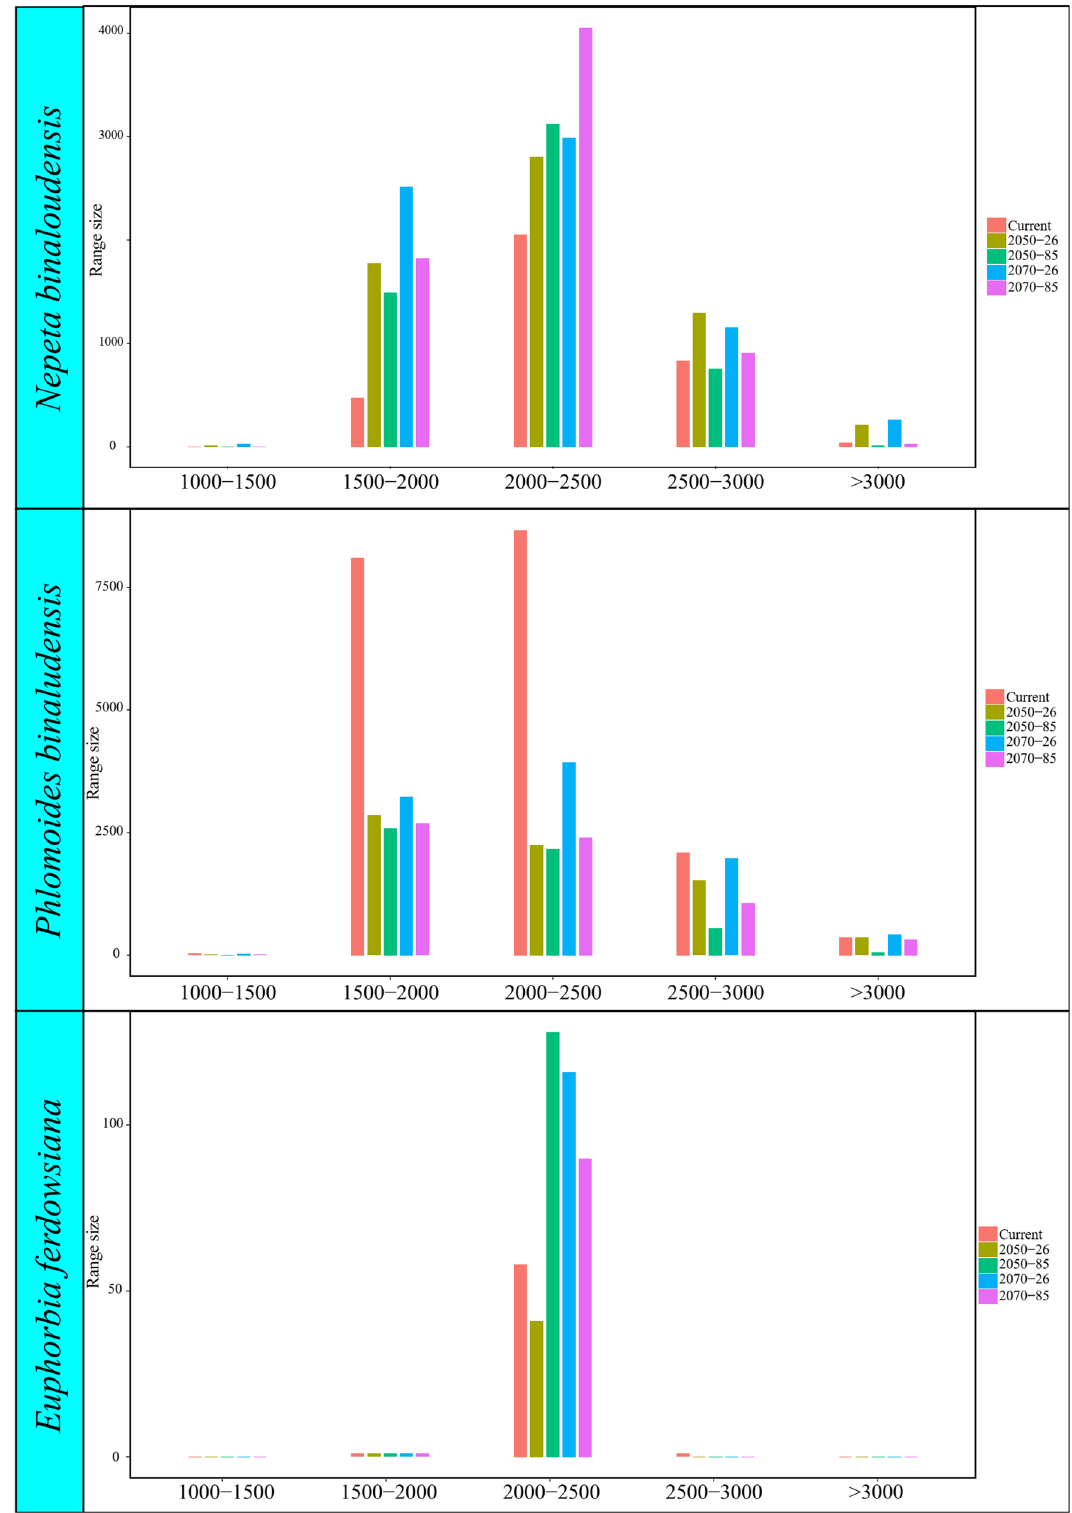
Figure 5. Range size of the studied species in relation to elevation classes under current and future climate change